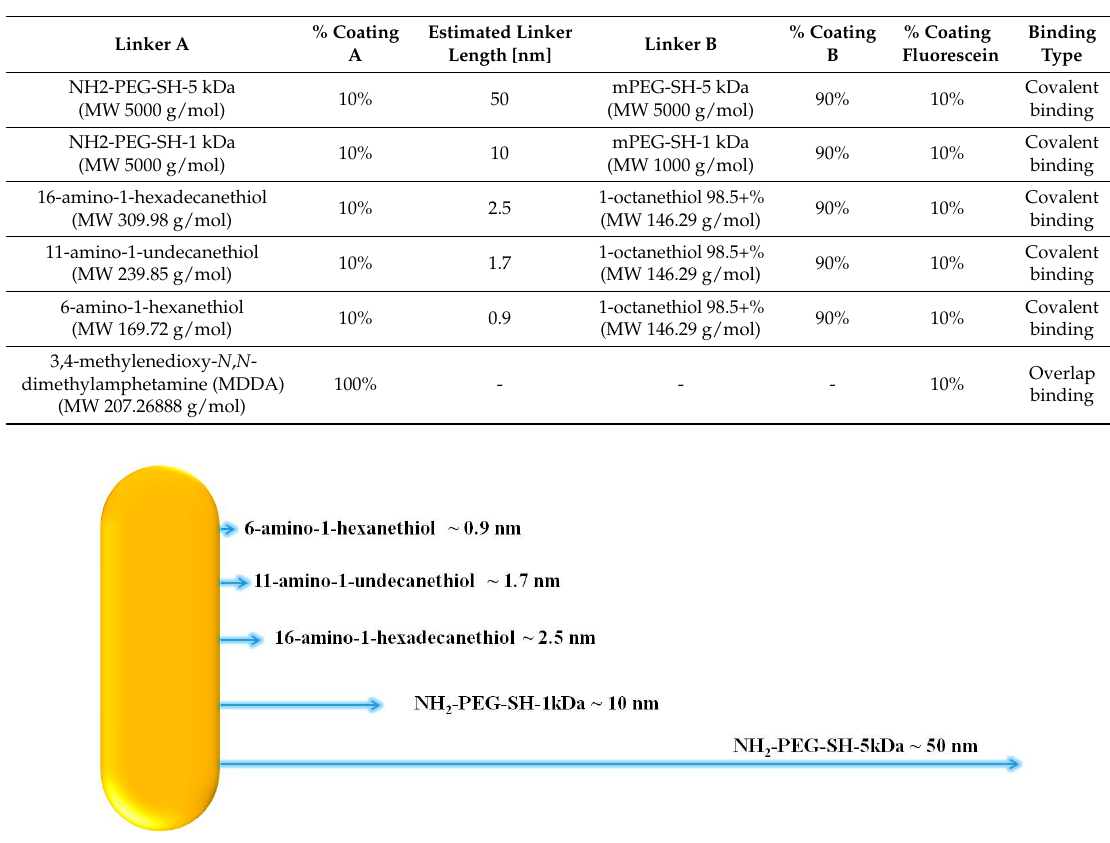
Table 3. This table lists the different linkers’ mixtures, the percentage of each linker in these mixtures and the matching fluorescein coating percentage.